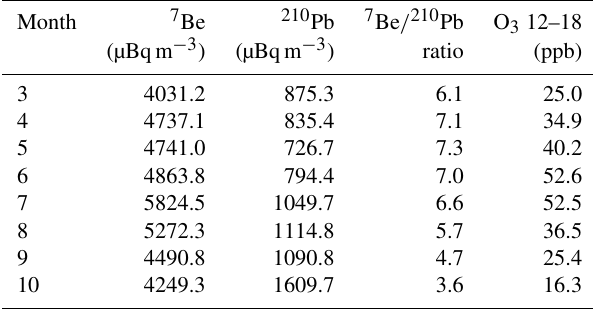
Table 2. Monthly averages of 7 Be, 210 Pb, ozone (12:00–18:00) concentrations and 7 Be / 210 Pb ratio during the March–October pe- riod